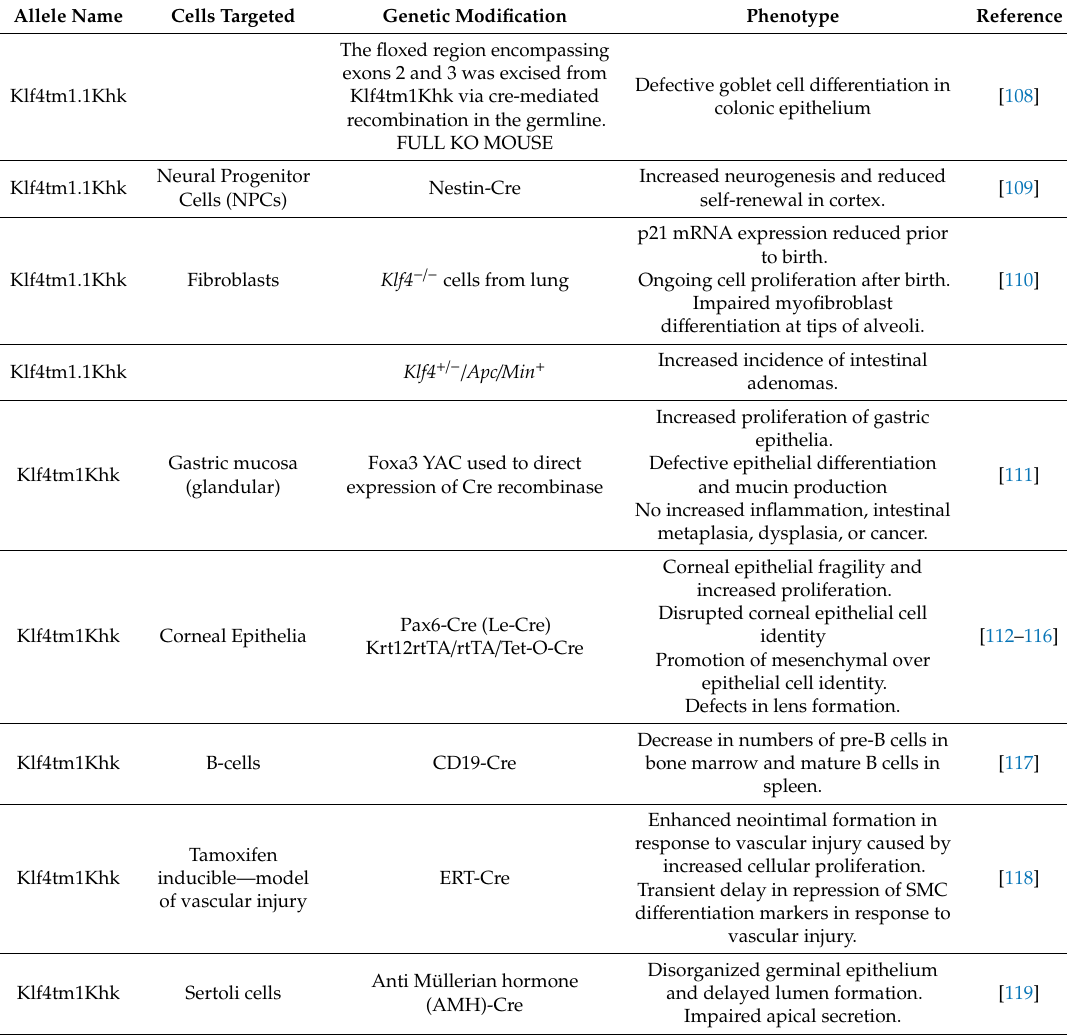
Table 2 for a summary of tissue-specific deletion approaches in murine models). Table 2. Summary of animal models used to investigate KLF4